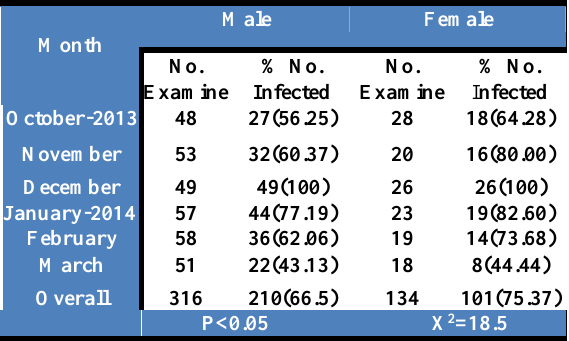
2: Prevalence of abomasal nematodes according to sex of sheep